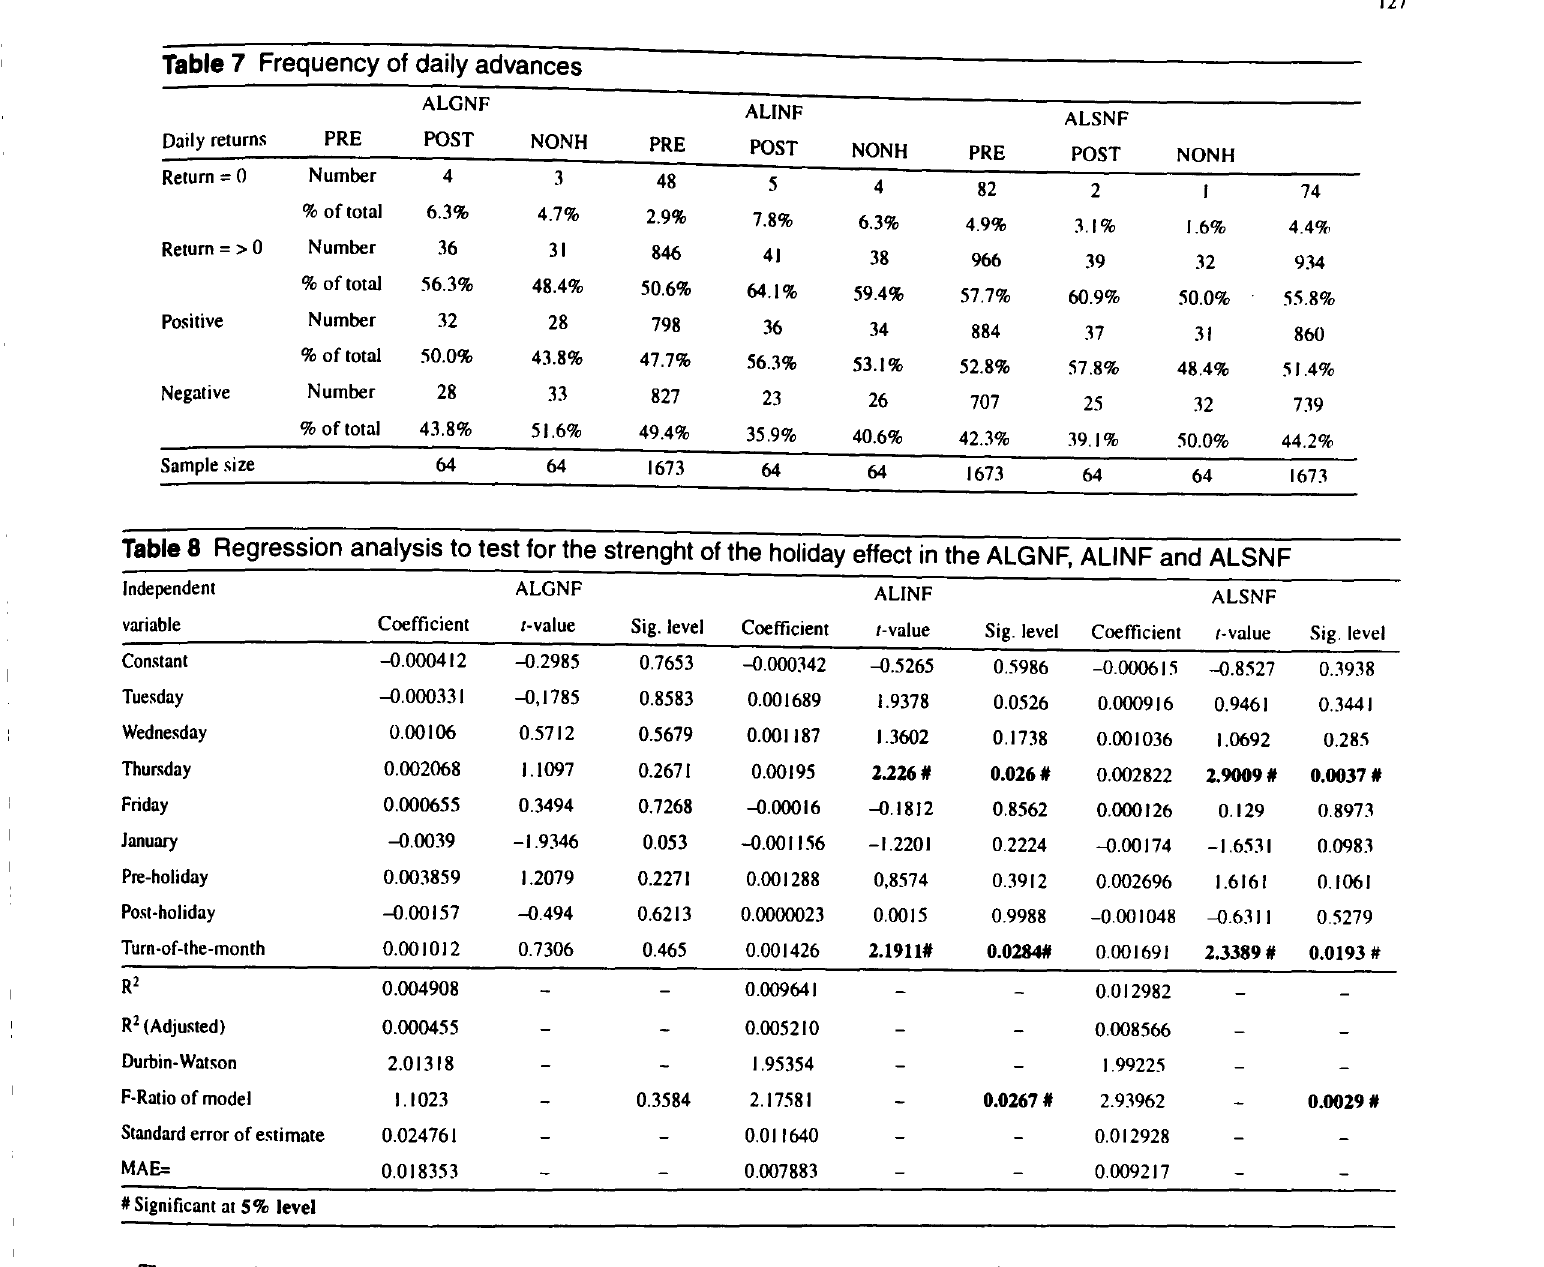
Table 8 Regression analysis to test for the strenght of the holiday effect in the ALGNF, ALINF and ALSNF